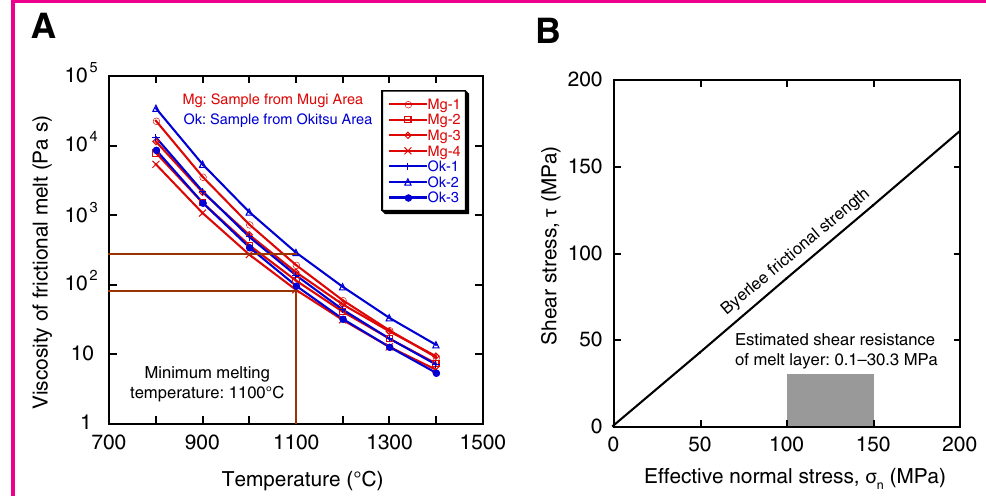
Figure 2. Estimated viscosity and shear resistance of the melt layer. [A] Viscosity versus temperature for seven samples from the Mugi and Okitsu areas. [B] Shear stress versus effective normal stress for the melt layer, compared with Byerlee’s frictional strength .